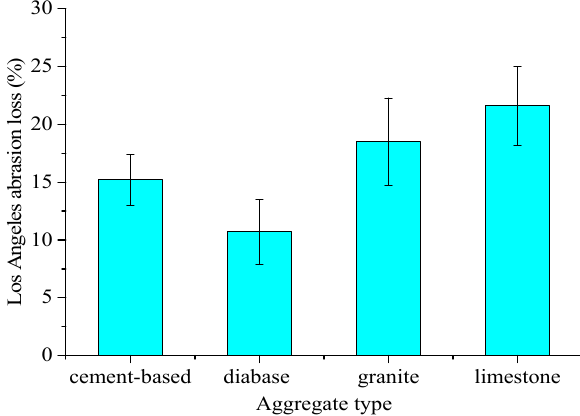
Figure 17. Los Angeles abrasion test results of different aggregates.